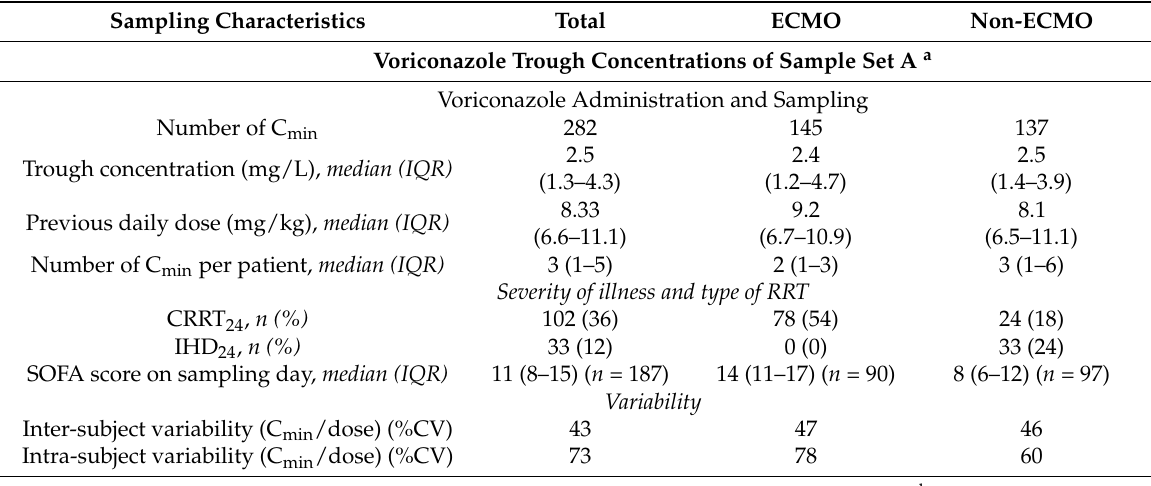
Table 2. Voriconazole trough samples.